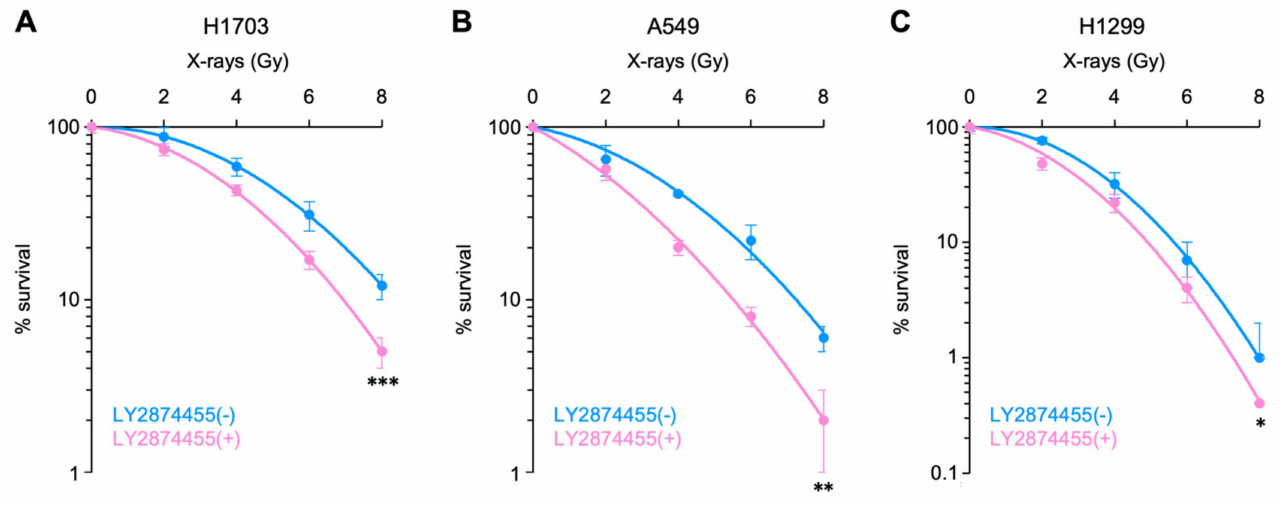
Figure 1. Radiosensitizing effect of LY2874455 in cancer cells. Clonogenic survival of H1703 ( A ), A549 ( B ), or H1299 ( C ) cells exposed to LY2874455 (100 nM) from 1 h pre-irradiation to 10 days post- irradiation is shown (mean ± s.d., n = 4). *, p < 0.05; **, p < 0.01; and ***, p < 0.001 (ANCOVA test). Table 1. Linear–quadratic model parameters for the survival curves.